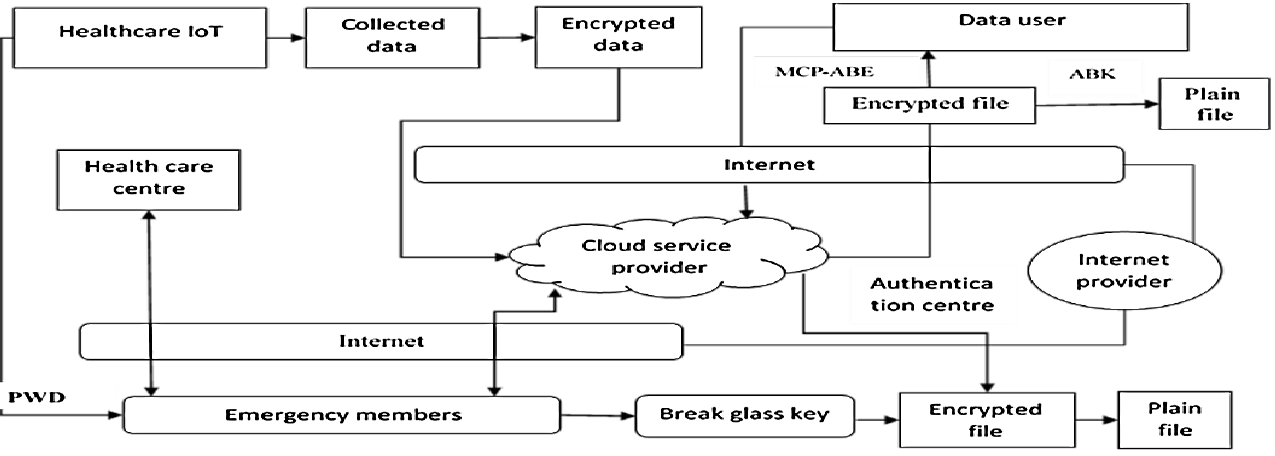
Figure 1. Proposed model